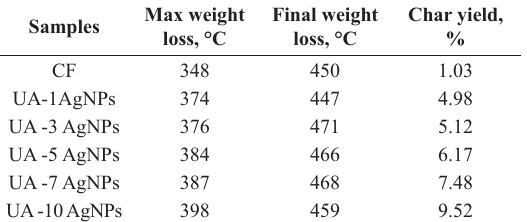
Figure 5. Transmission spectra of photocured